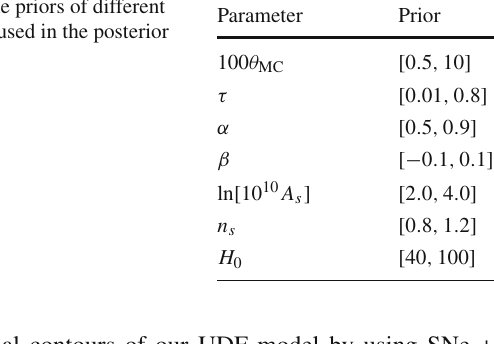
straints, we list the priors on the parameter space in Table 1. In Fig. 5, we exhibit the one-dimensional marginalized probability distribution on the individual parameter and two-